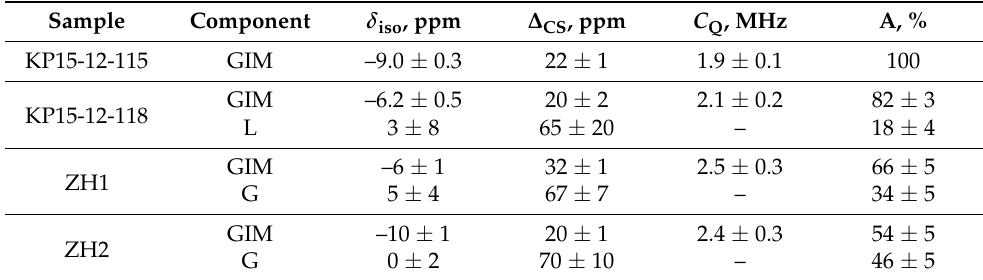
Table 3. The fitted parameters of the 23 Na MAS NMR of the impact glasses.